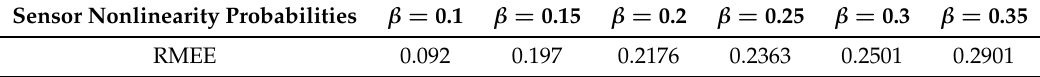
Table 1. Root mean-square estimation error (RMEE) of system state 1 with the increased probabilities.